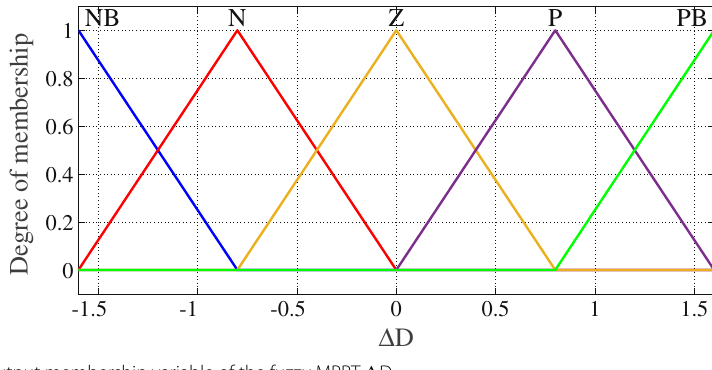
Fig. 8 Output membership variable of the fuzzy MPPT (cid:31)